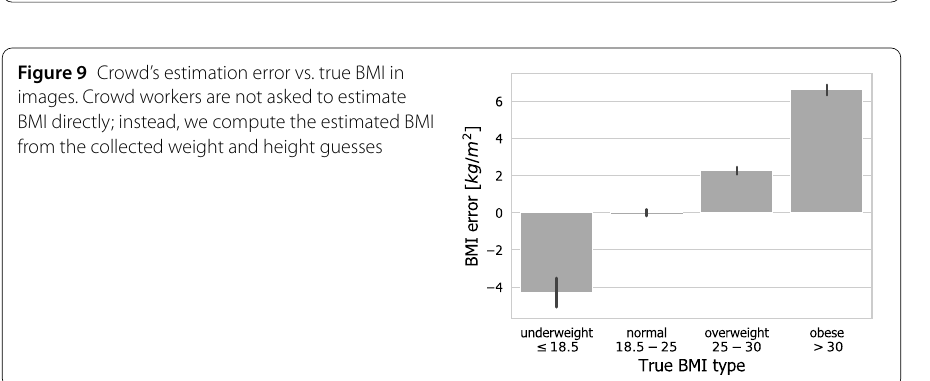
Figure 9 Crowd’s estimation error vs. true BMI in images. Crowd workers are not asked to estimate BMI directly; instead, we compute the estimated BMI from the collected weight and height